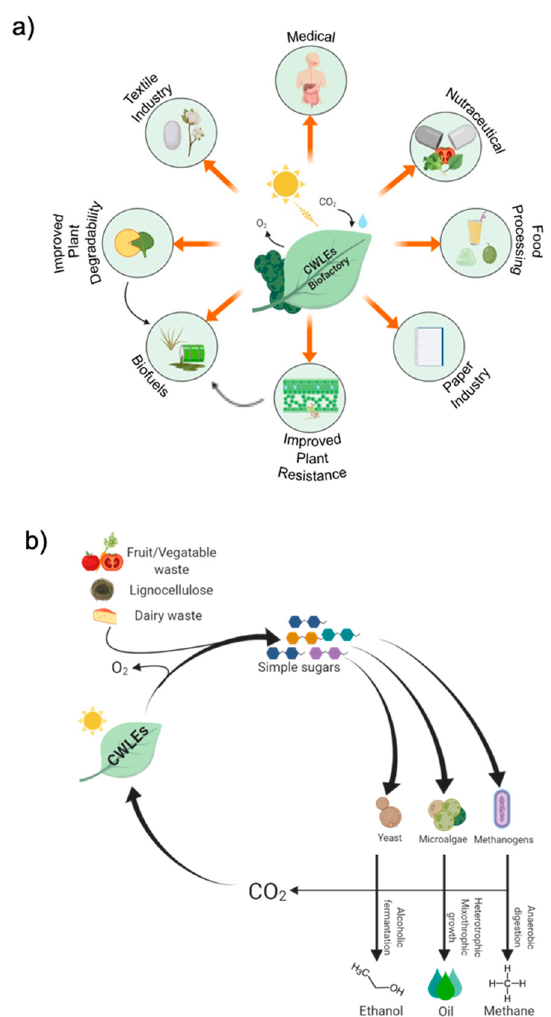
Figure 4. Biotechnological applications of CWLEs. ( a ) Possible applications of plant-expressed CWLEs in agriculture, industrial, and medical fields; both an increased degradability and biomass productivity positively impact the release of fermentable sugars from plant biomass. ( b ) Use of plant-expressed CWLEs for the production of second- and third-generation biofuels; sugars released from waste materials upon CWLE-treatment are used as feed for yeasts, microalgae, and methanogenic bacteria. CO 2 emitted from these metabolic processes may be converted into CWLEs and O 2 by the plant biofactory.